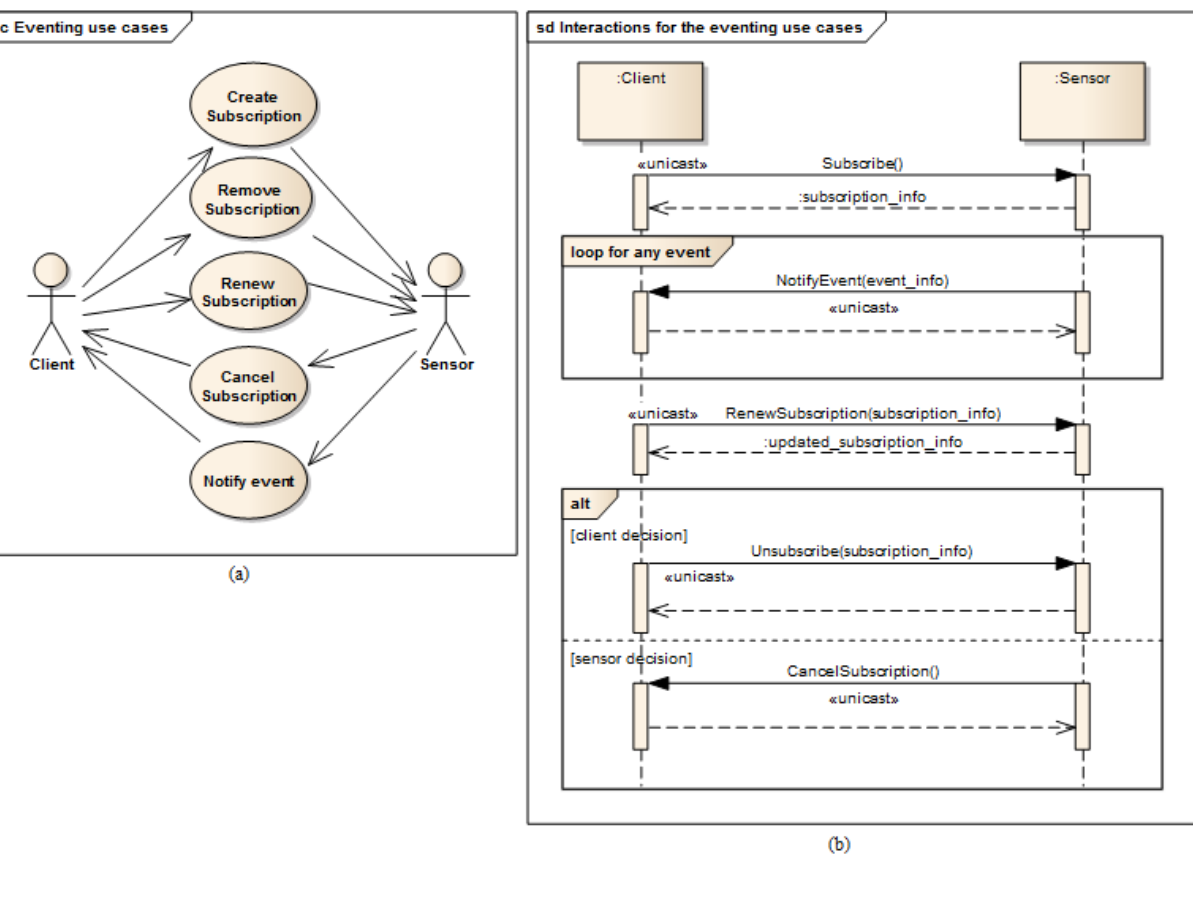
Figure 4. Event management use cases ( a ) and behavior ( b